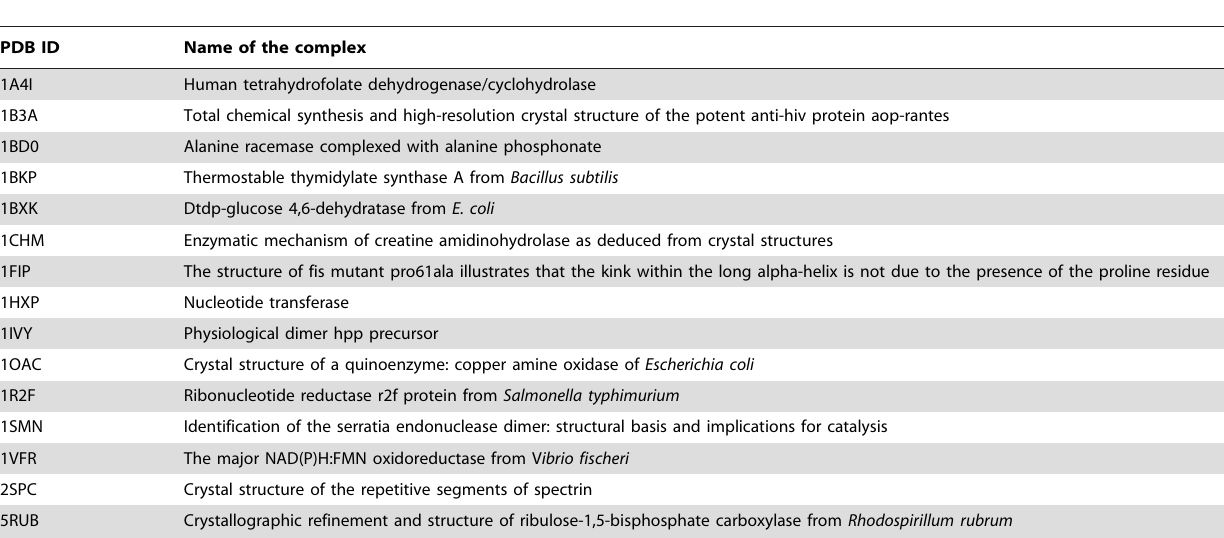
Table 1. List of 15 homodimers (chain A and B) used for training the scoring scheme.